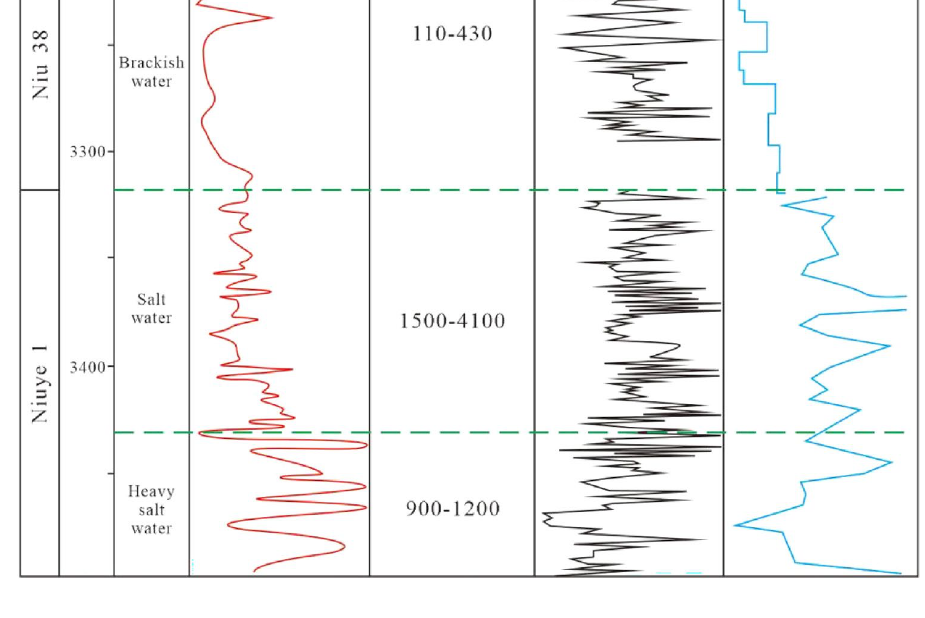
Fig. 5 Paleoproductivity of main source rocks in the Jiyang Depression